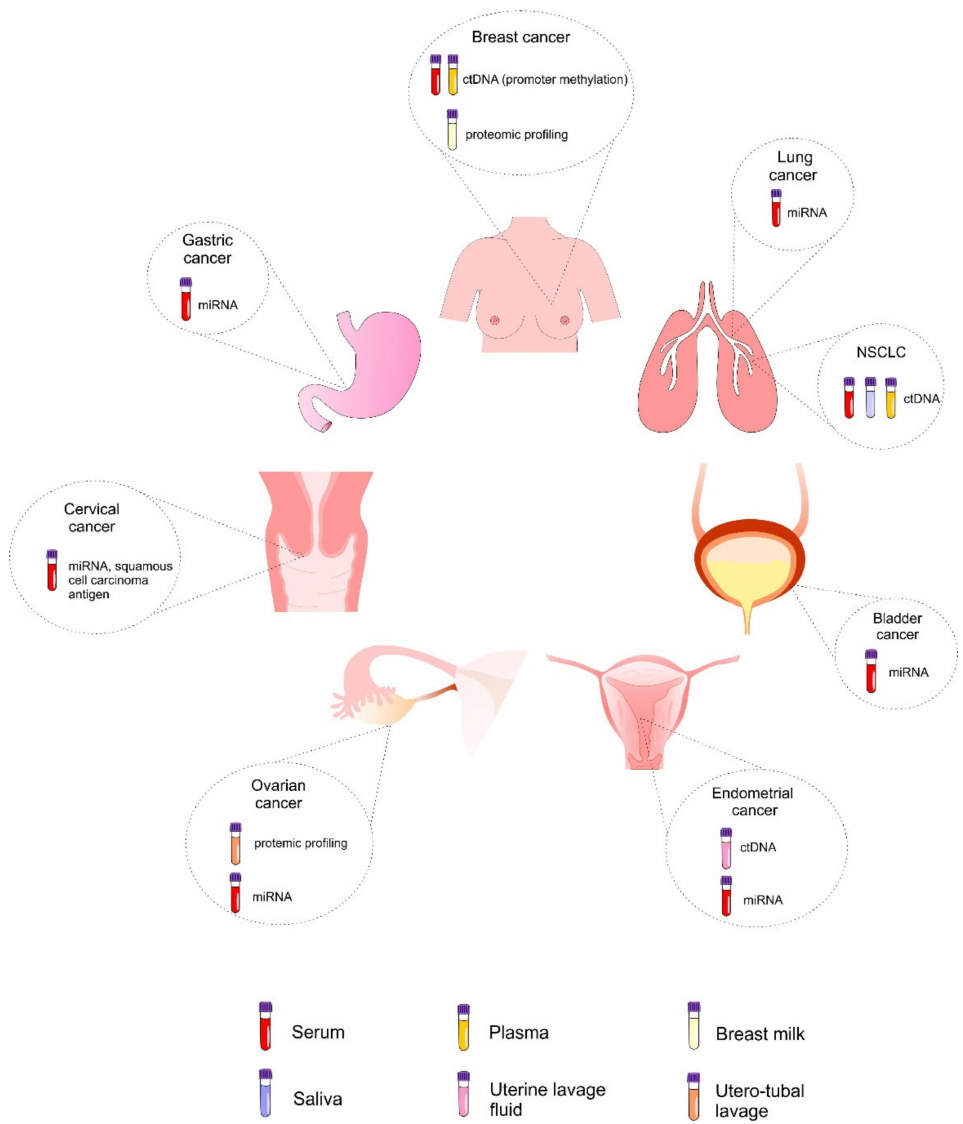
Figure 3. Biomarkers of liquid biopsy obtained from various samples of bio-fluids used for the early detection of selected cancer types. Abbreviations: ctDNA, circulating cell-free tumor DNA; miRNA, microRNA; NSCLC, non-small cell lung